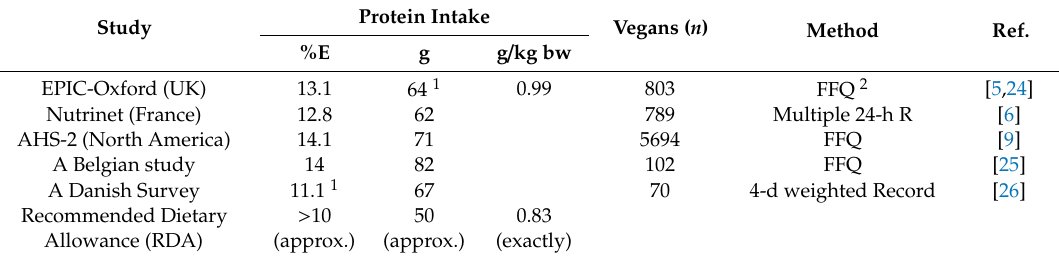
Table 3. Average protein intake of vegans based on di ff erent samples in the